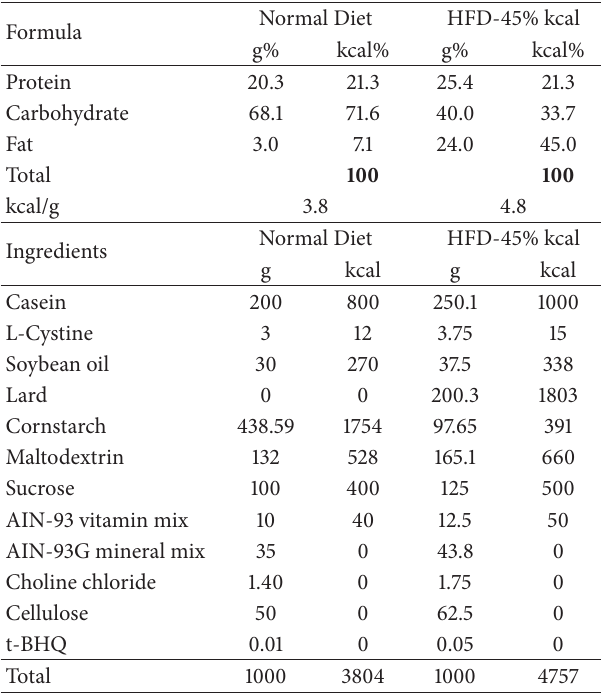
Table 1: Composition of experimental